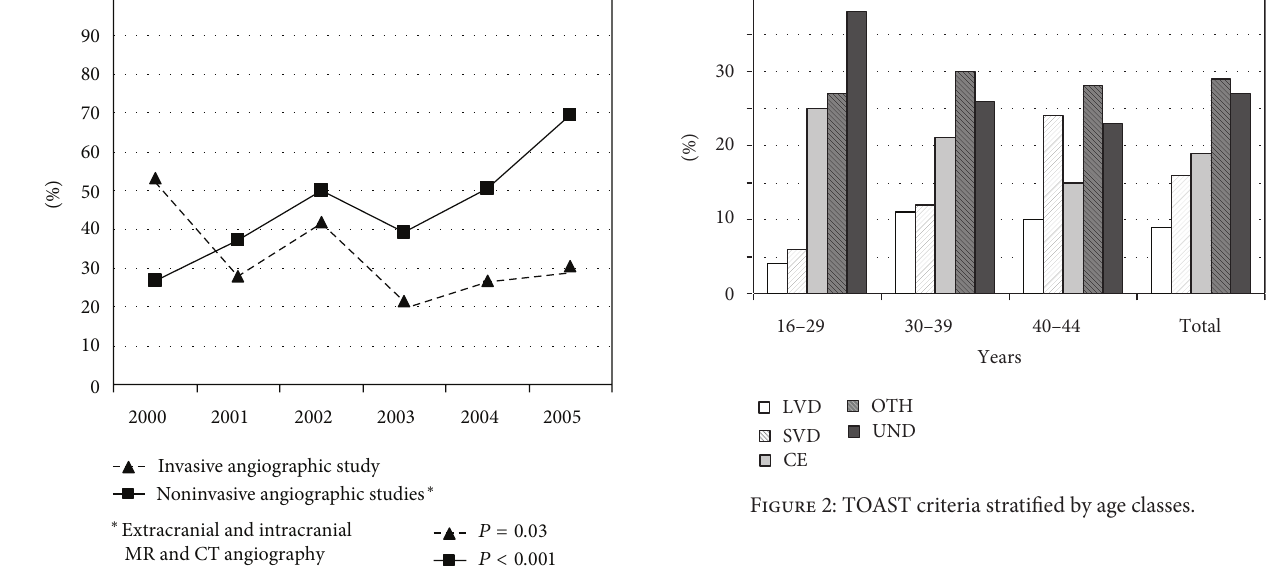
Figure 1: Changes over time (2000–2005) of the frequency of angiographic studies.